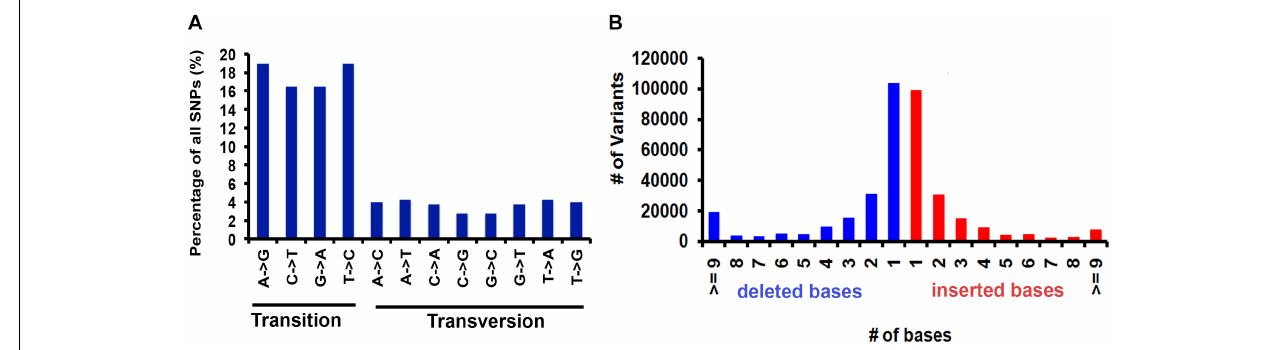
FIGURE 2 | Base distribution statistics of variants identified in PP genome. (A) Percentage of transition and transversions. (B) Distribution of deleted and inserted bases.